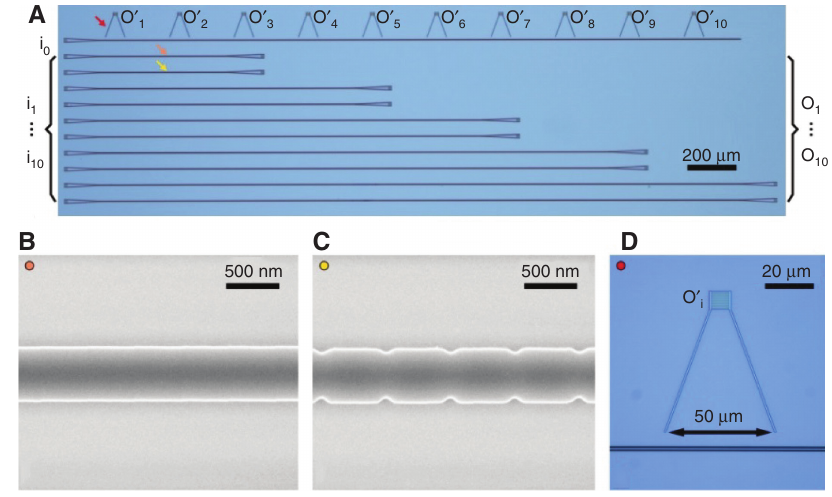
Figure 4: The fabricated SWGAs. (A) Optical microscopy image for fabricated Si waveguides and SWGAs with varied propagation length l waveguide and (C) SWGA. (D) Enlarged optical microscopy image for the fabricated shallow-ridge taper.